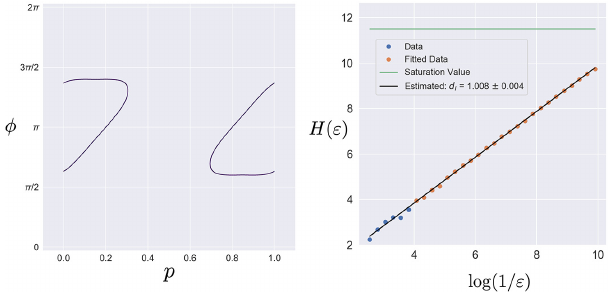
FIG. 6. Left: quasiperiodic orbit with dynamic generated by the standard map at K = 2 and initial conditions ( p 0 , φ 0 ) = ( 0.2, π) . Right: numerical estimation of the information dimen- sion, obtained by extracting the growth rate of H ((cid:11)) , shorthand for H ( Z (cid:11) ) , as a function of log ( 1 /(cid:11)) . The estimated value is consistent, up to two significant digits, with the expected D =